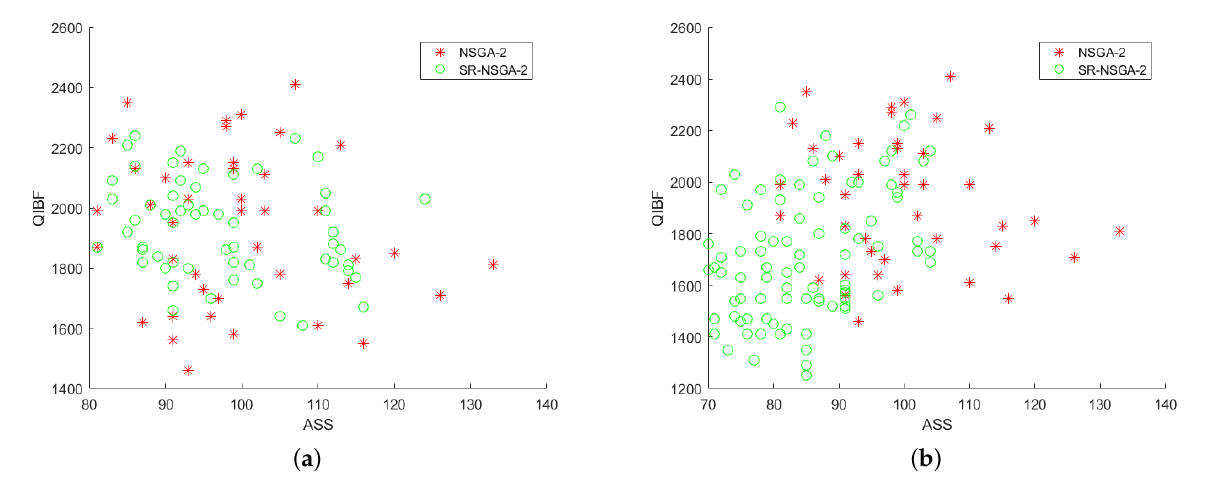
Figure 14. Operator iteration of NSGA-2 and SR-NSGA-2 for the SORA problem.